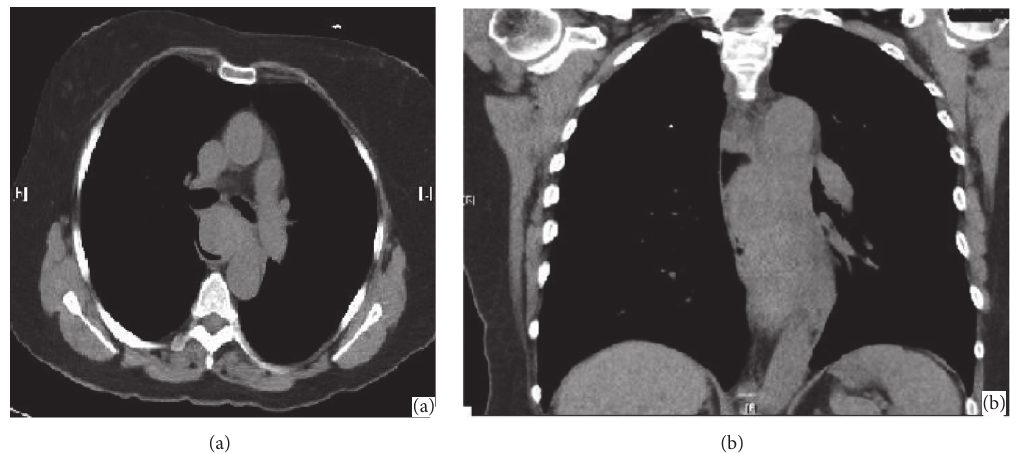
Figure 1: Initial CT demonstrating the long intramural oesophageal haematoma ((a) sagital and (b) coronal view).